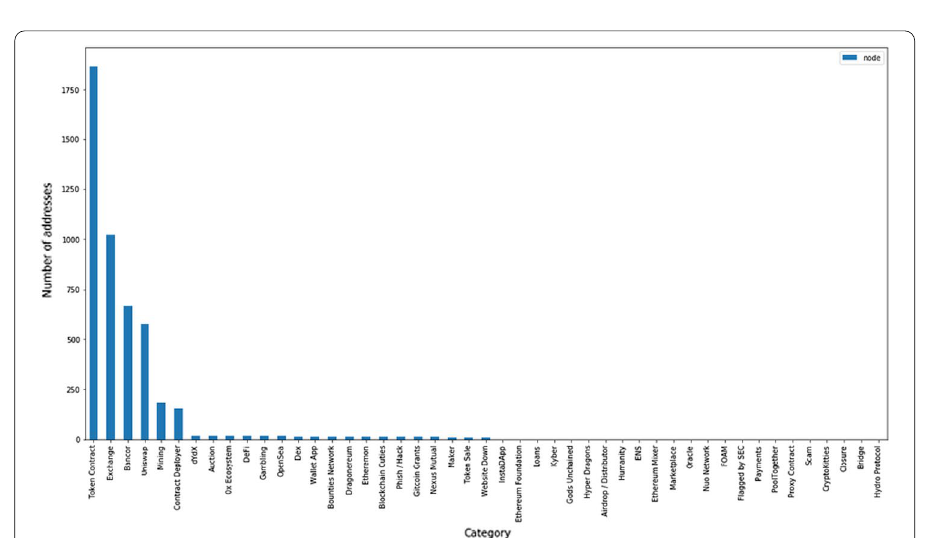
Fig. 2 Distribution of Ethereum training addresses against the main Etherscan